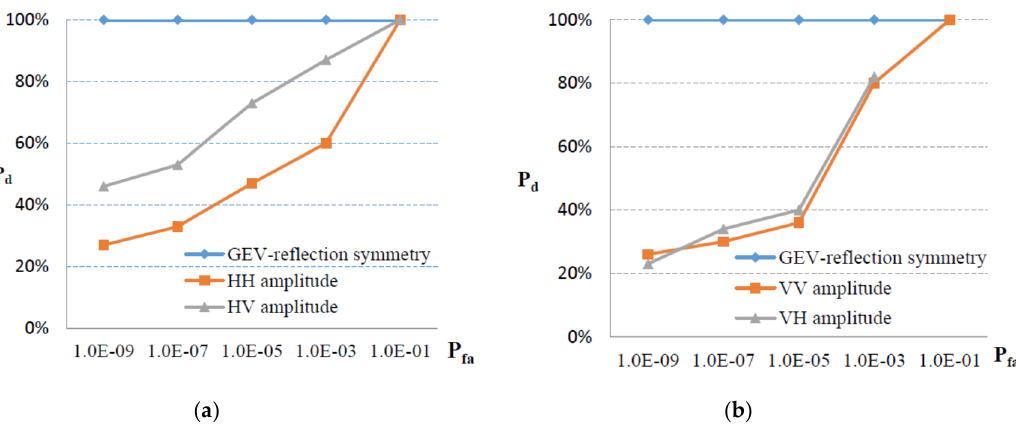
Figure 6. Detection results comparison with receiving operating characteristic (ROC) curves ( a ) data set 1; ( b ) data set 2.